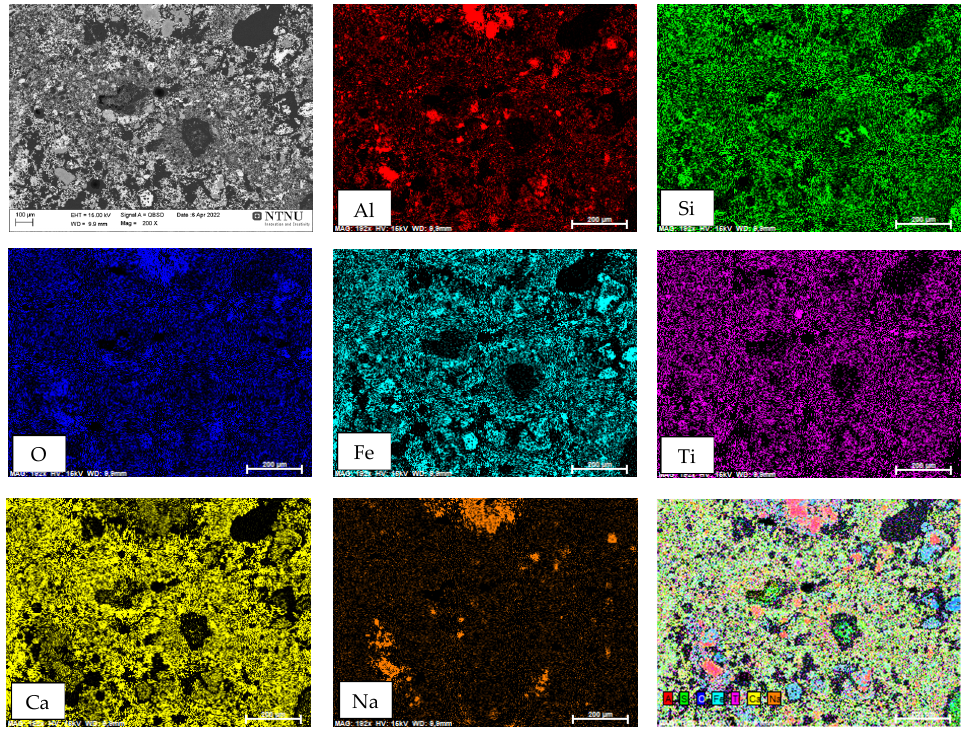
Figure 10. EDS elemental mapping of C 1.15 A sintered at 1150 °C.